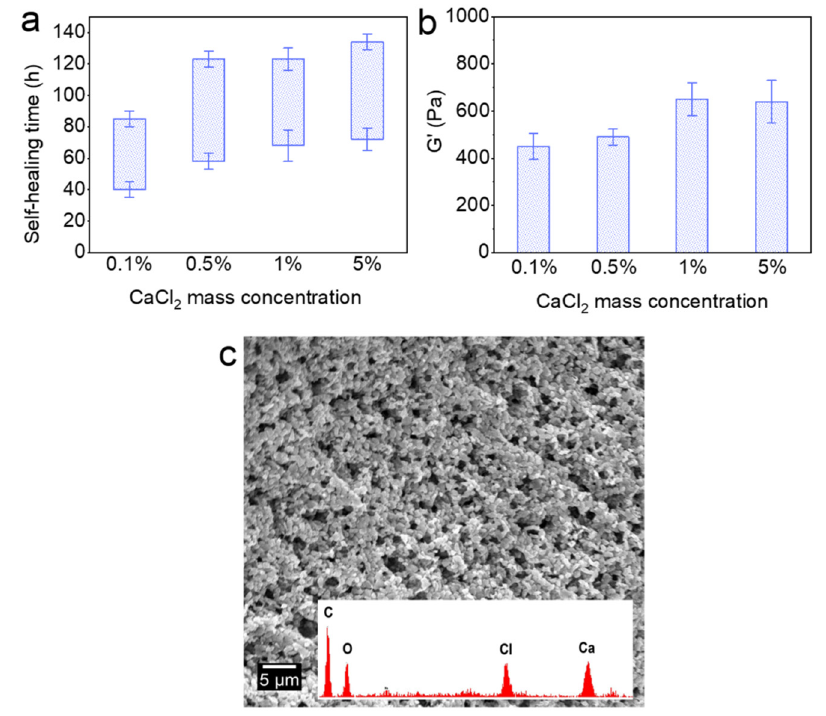
Figure 5. Self-healing of the Alg-IPNG gels at 65 °C: ( a ) self-healing time; ( b ) elastic modulus (G’) of the healed gel; and ( c ) micro-structure of the healed gel.